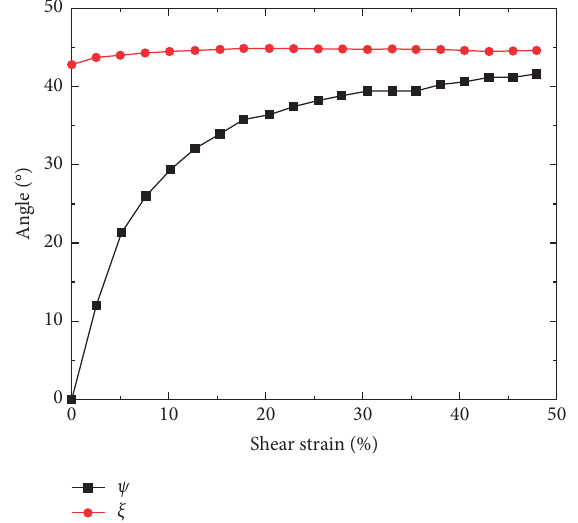
Figure 15: Rotation of principal stress and principal strain